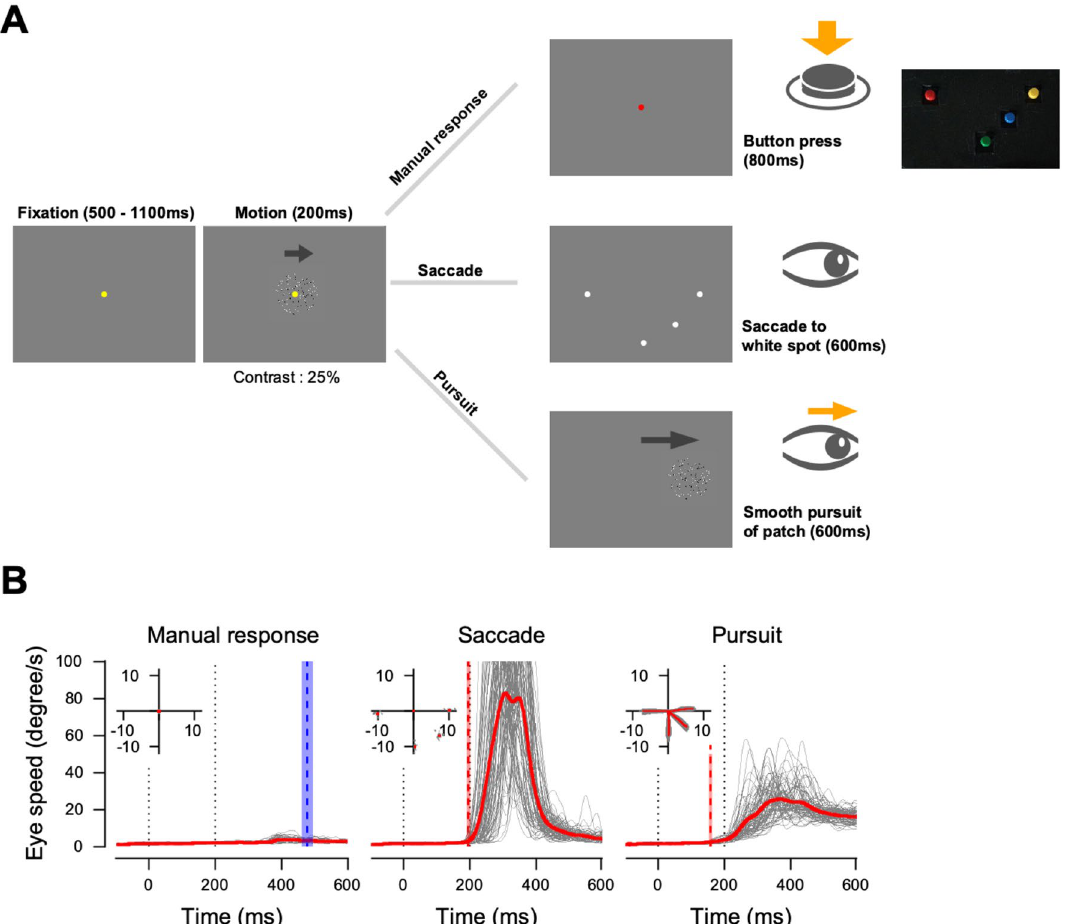
Figure 1. Task design and behavioral results with eye movement traces. ( A )Task design: Human participants were instructed to report the motion direction of a visual stimulus presented at the center of the screen. During the motion period, only dots inside the patch moved coherently in a specific direction. After this period, participants had to report the perceived direction using button press, saccade, or pursuit eye movements. ( B ) Behavioral results for all participants: Insets show average (red) and individual (gray) eye positions for each direction condition. The main figures show participants’ individual (gray) and average (red) eye speeds. The red dashed lines indicate the average reaction time across participants. The blue dashed line in the left column (manual response) indicates the average reaction time for button presses across participants. Shaded red and blue areas around each dashed line denote standard error. The vertical black dotted lines in each plot indicate the start and end of the motion